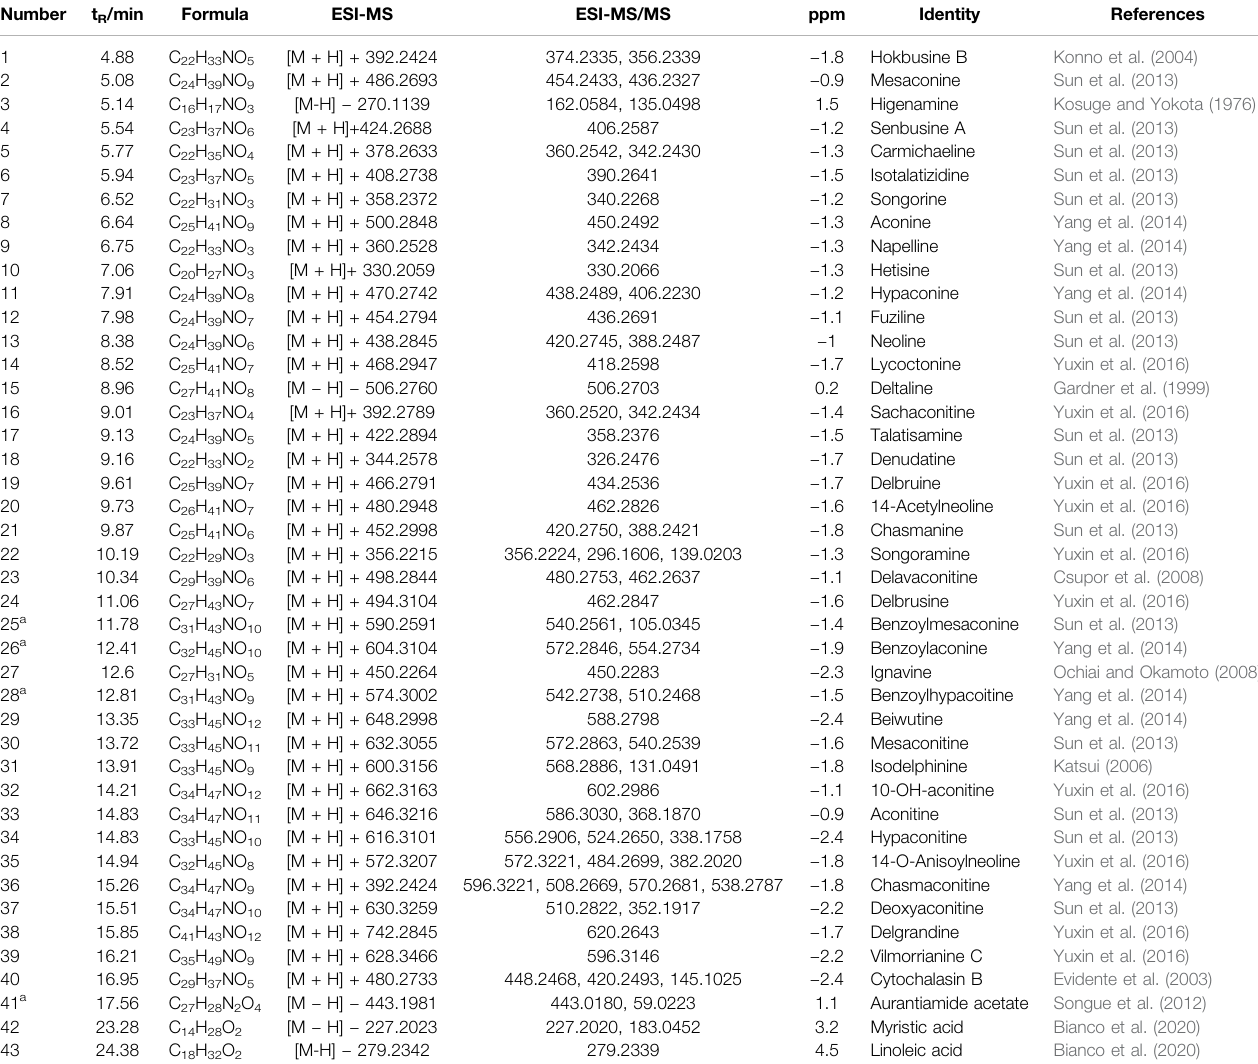
TABLE 1 | Characterization of the chemical constituents in ARC by ultraperformance liquid chromatography quadrupole time-of- fl ight tandem mass spectrometry. Number t R /min Formula